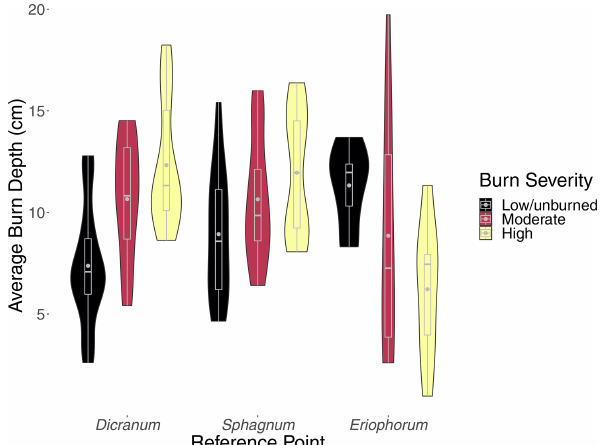
Figure A4. The distributions of average burn depth per transect within each reference point (including Eriophorum vaginatum ) across burn severity. Boxes encompass the middle 50% of data, whiskers are the upper and lower quartiles, horizontal lines intersecting boxes show the median, and gray points are the mean.